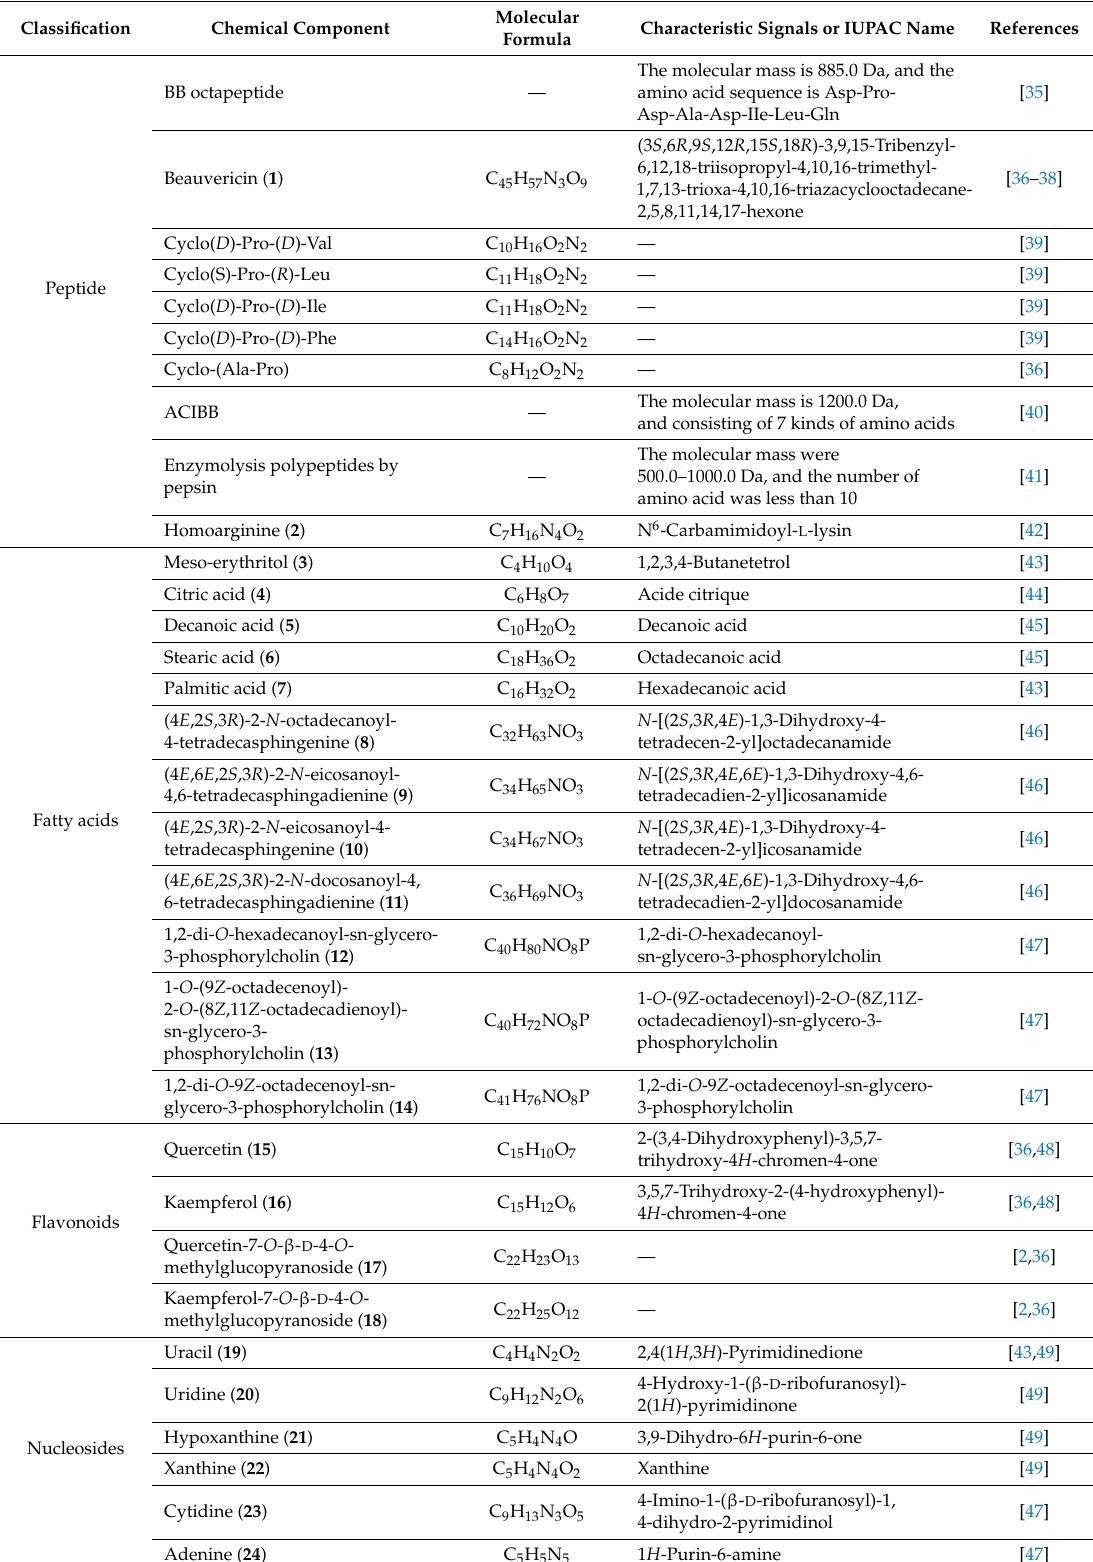
Table 2. Chemical constituents isolated from B. batryticatus